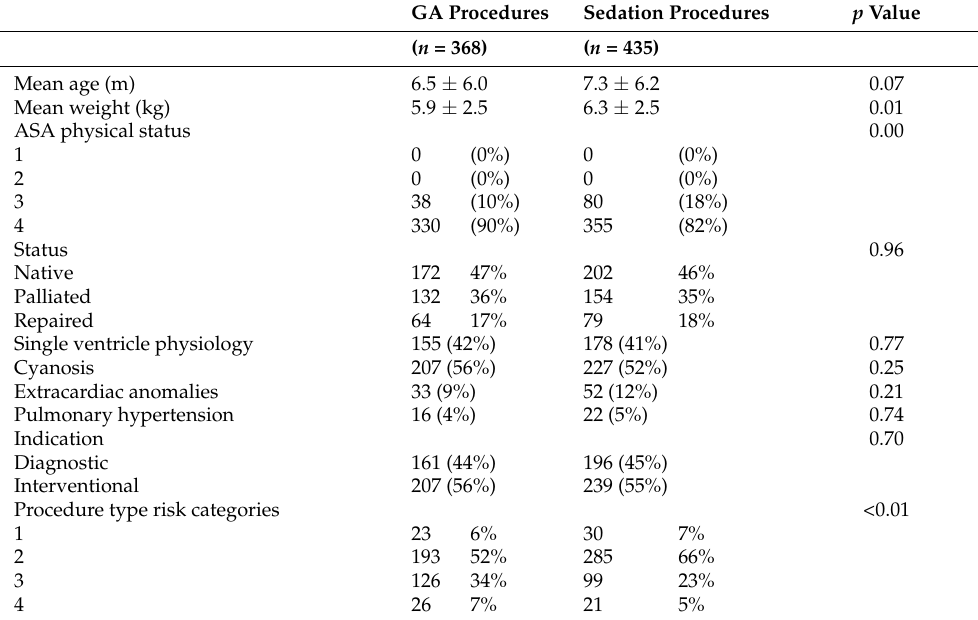
Table 2. Pre-procedural characteristics of patients.